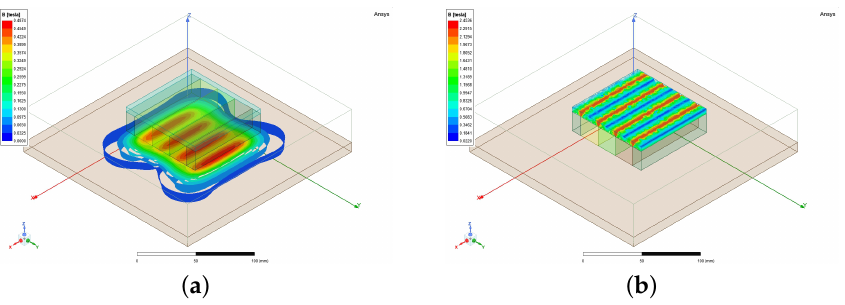
Figure 9. Simulation results for opposite magnetization. ( a ) Cloud map of the magnetic flux intensity on the test steel plate. ( b ) Cloud map of the magnetic flux intensity on the yoke.